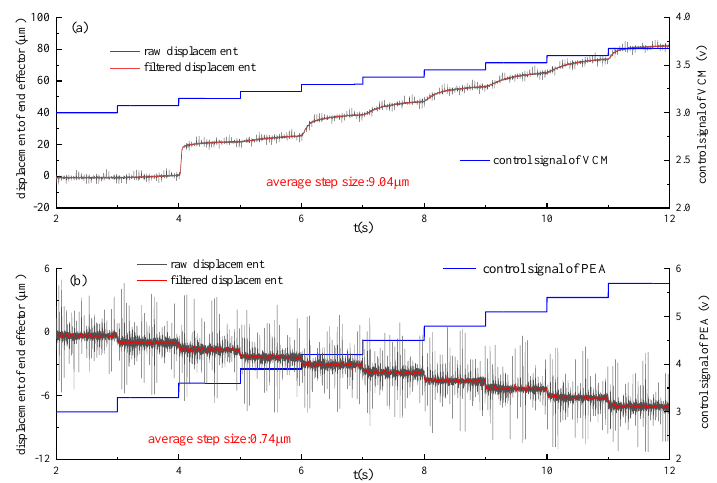
Figure 10. Motion responses with consecutive step control signals applied on ( a ) VCM, ( b ) PEA.